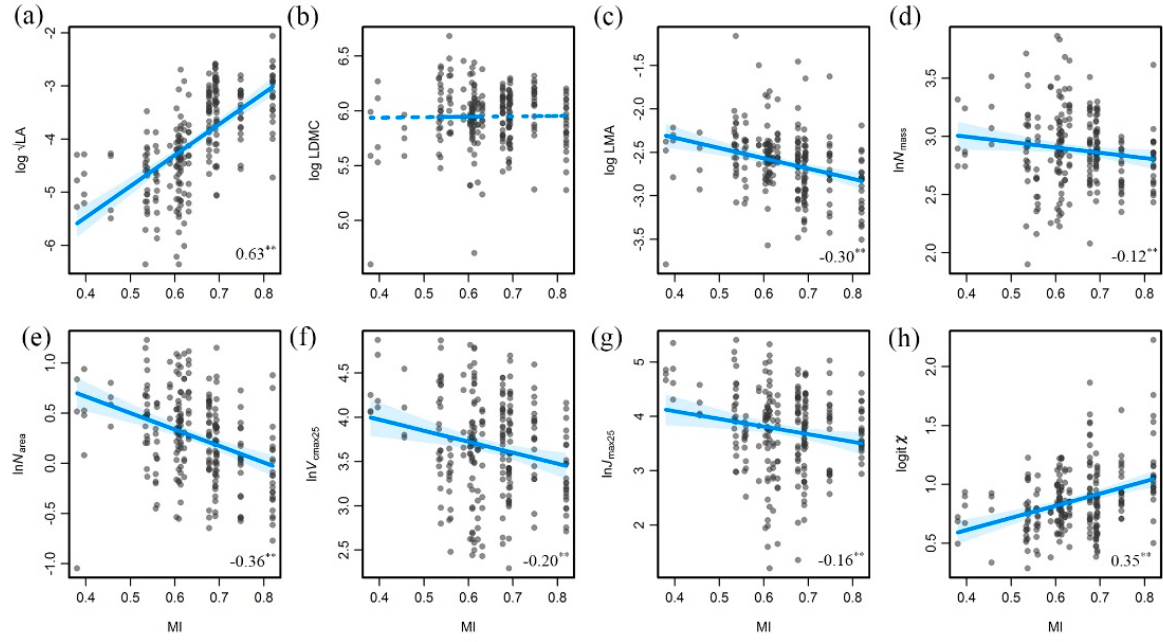
Figure 4. Trait variations along the aridity gradient (decreasing moisture index, MI). ( a ) LA versus MI. ( b ) LDMC versus MI. ( c ) LMA versus MI. ( d ) N mass versus MI. ( e ) N area versus MI. ( f ) V cmax25 versus MI. ( g ) J max25 versus MI. ( h ) χ versus MI. The bottom right numbers are the correlation coefficients and their significance, with “**” indicating p < 0.01. LA: leaf area; N mass : leaf nitrogen content per mass; N area : leaf nitrogen per area; LMA: leaf mass per area; LDMC: leaf dry mass content; V cmax25 : maximum carboxylation rate standardized to 25 ◦ C; J max25 : maximum electron transport rate standardized to 25 ◦ C; χ : ratio of intercellular to ambient CO 2